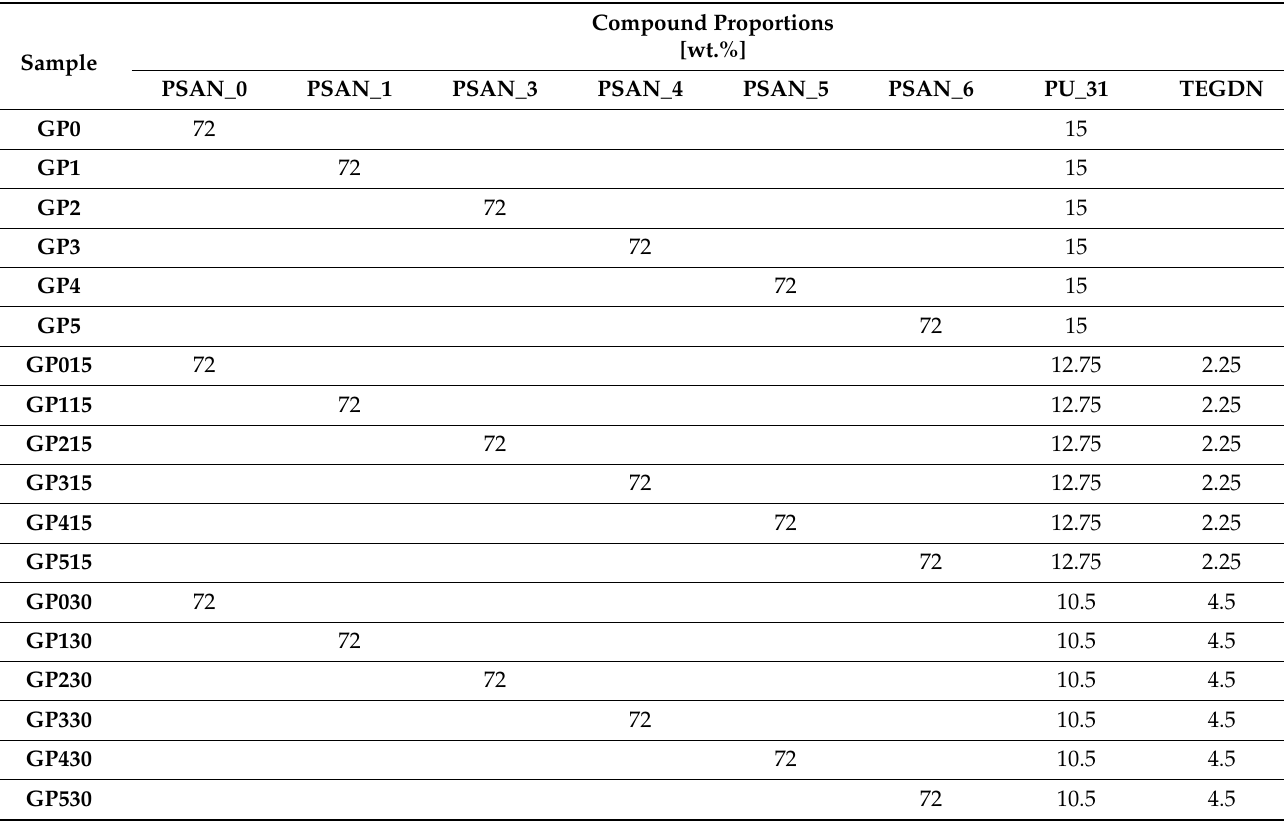
Table 2. “Green” rocket propellant composite formulations.